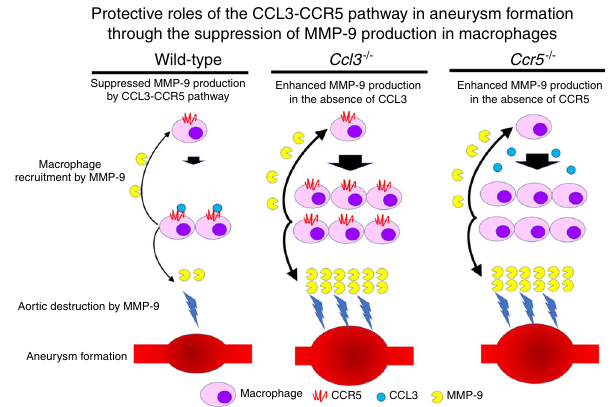
Fig. 10 Schema of the protective roles of the CCL3 – CCR5 pathway in aneurysm formation. The illustration was created by